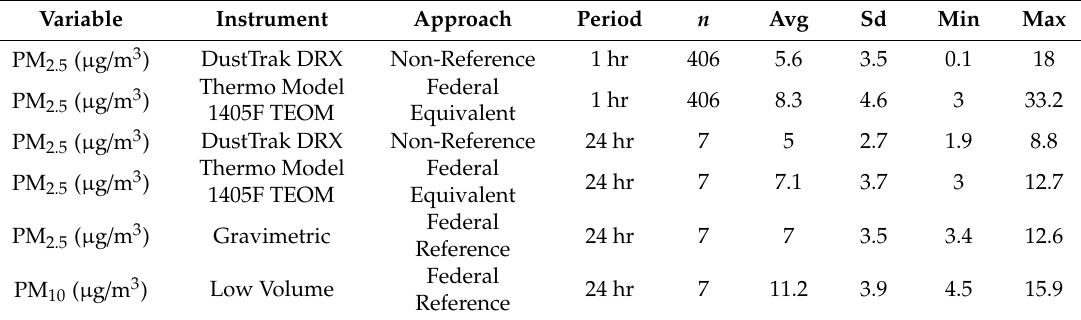
Table 1. Summary statistics for measurements during co-located